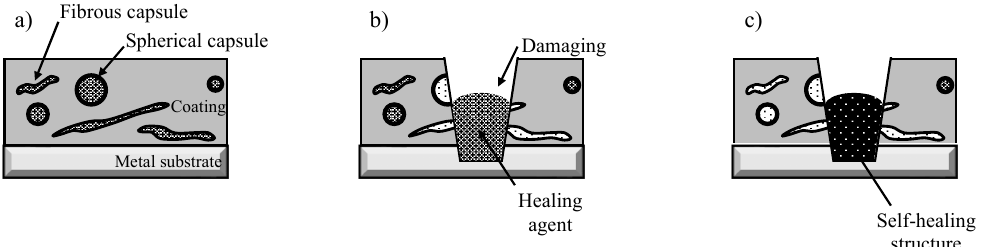
Figure 13. Schematic illustration of the structural change in SHC-SFC by physical damage. ( a ) Just before damage, polyurethane coating with dispersed spherical and fibrous capsules. ( b ) Just after damage, flowing-out of healing agent from broken capsules to damaged area. ( c ) At the last stage of aging, repairing the coating in the whole damaged area with a self-healing structure.